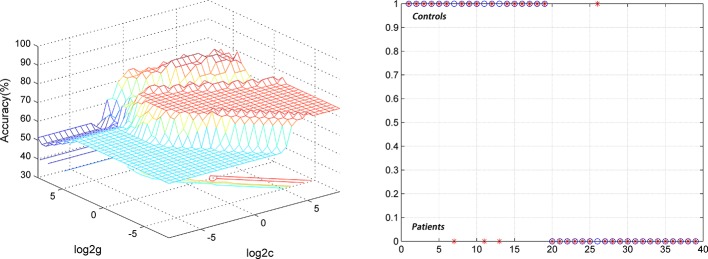
Using decreased NH values in the right PCC/precuneus to differentiate the patients (DPP group) from the controls. Visualization of classifications through support vector machine (SVM) using the NH values in the significantly different regions. Left: SVM parameters selection result of 3D view; Right: Classiﬁed map of the NH values in the right PCC/precuneus. SVM, support vector machine.